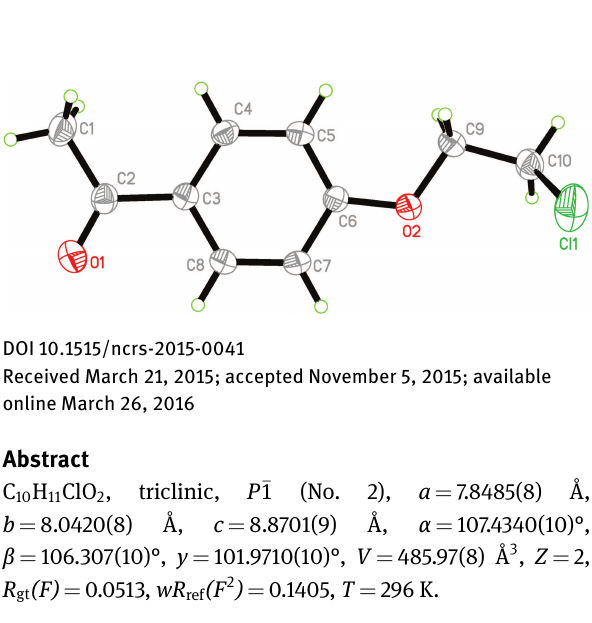
Table 1: Data collection and handling.